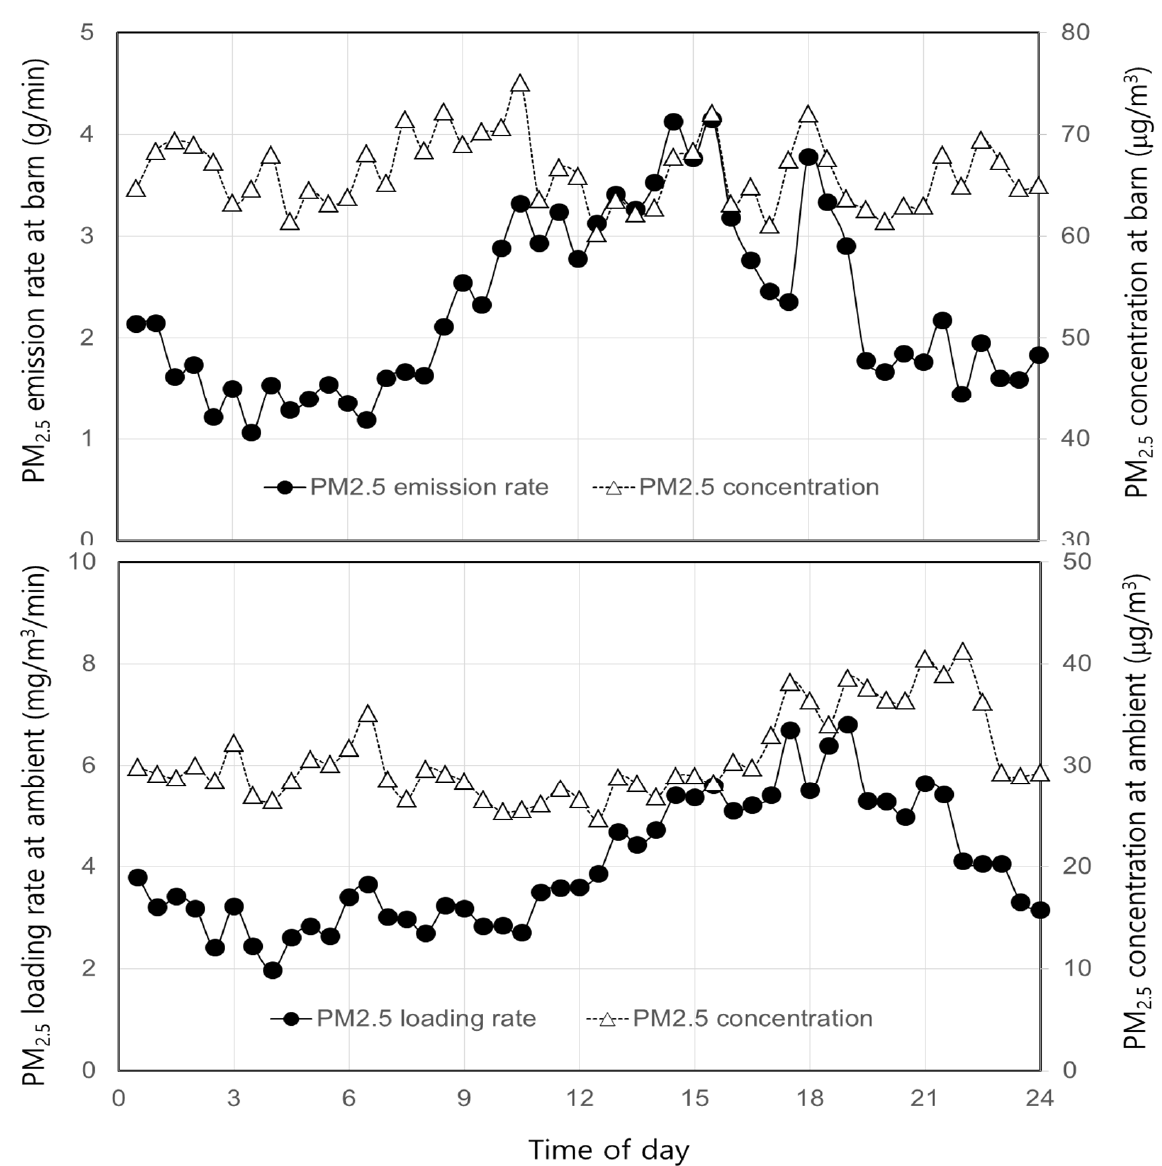
Figure 4. Diurnal profiles of PM2.5 mass emission rates and concentrations in the barns (upper) and in the ambient air (bottom).